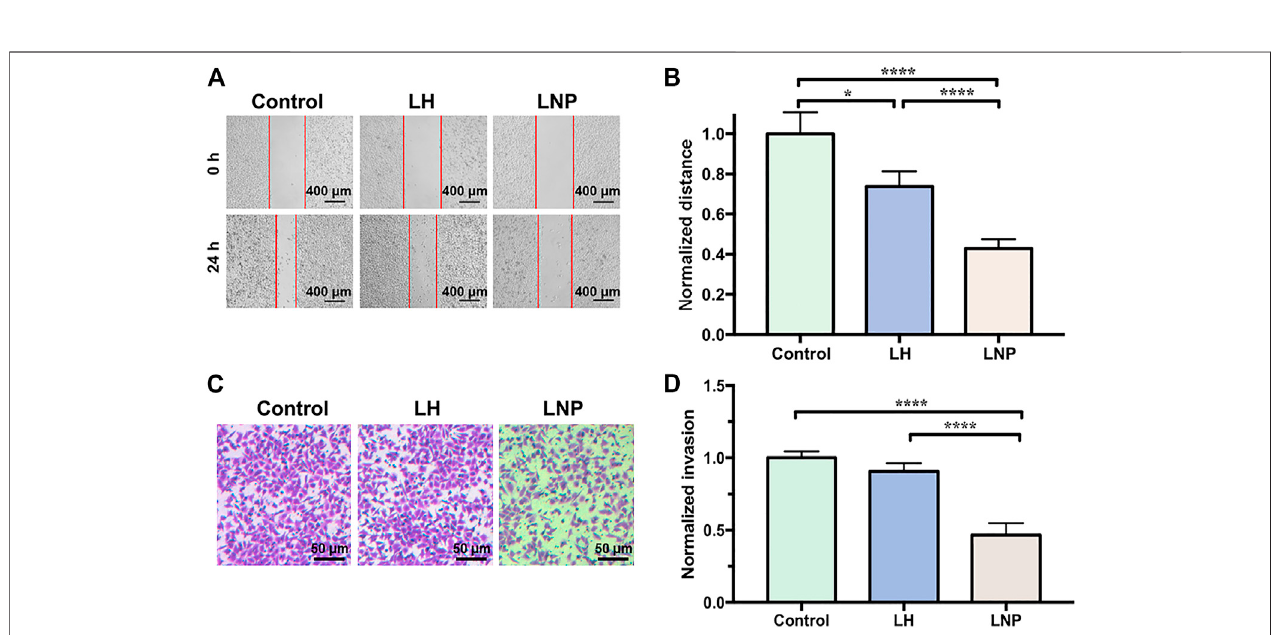
FIGURE 3 | LNPs inhibit migration and invasion of A375 cells. (A) representative images of wound healing, with the “ wound ” area marked by red lines. (B) comparisonofnormalizedmigrationdistancebetweendifferentgroups. (C) representativeimagesofcellsinvadedthroughthemembraneoftranswell. (D) comparisonof normalized invasion rate between different groups. * p < 0.05, **** p < 0.0001 by one-way ANOVA with Tamhane ’ s T2.